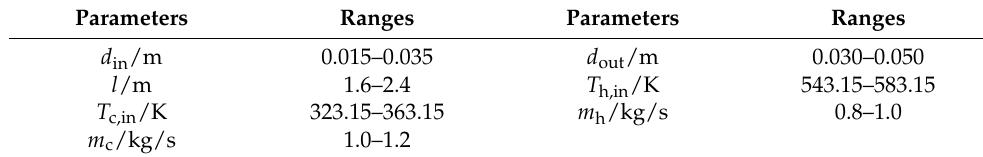
Table 3. Optimized parameters and